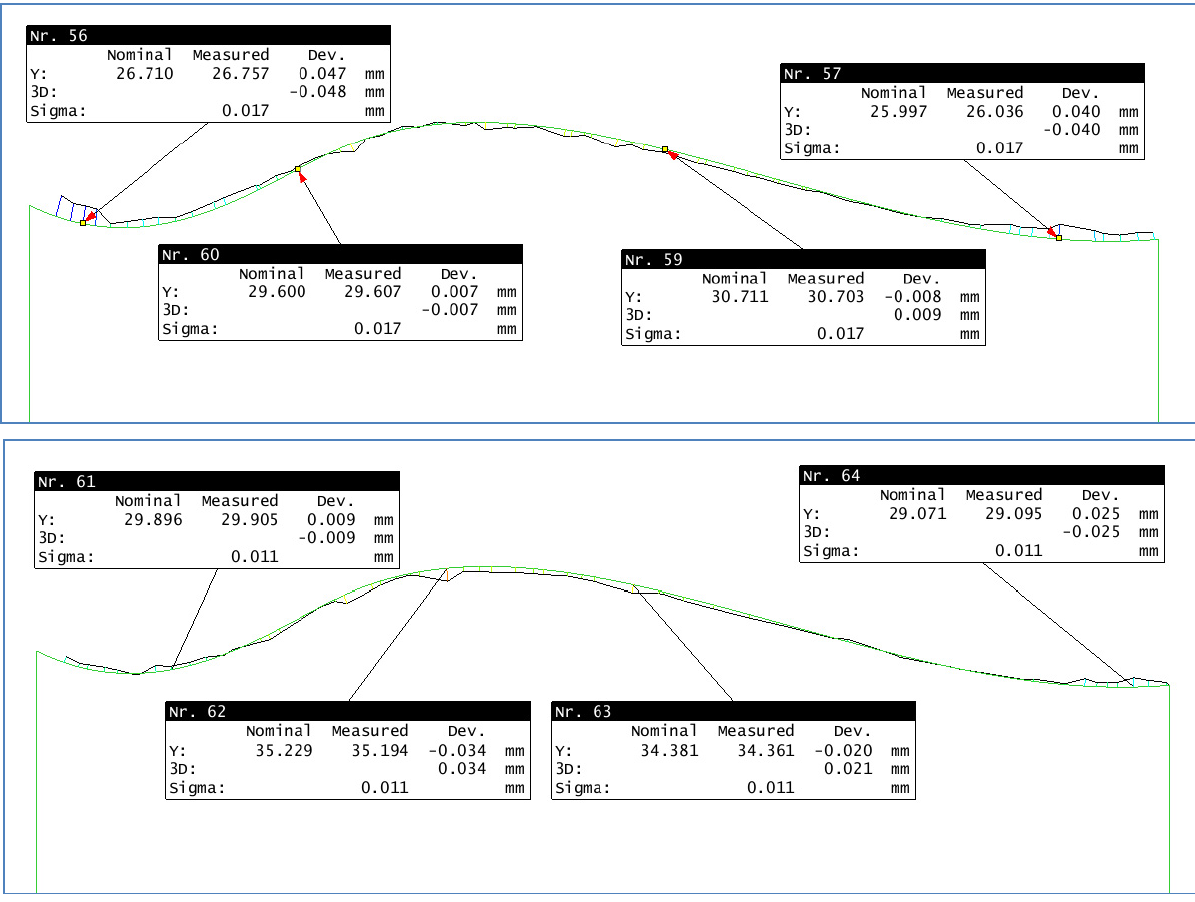
Figure 17. Evaluation of the deviations in the cross-section X=18 mm (above) and cross-section X=58 mm (below) for